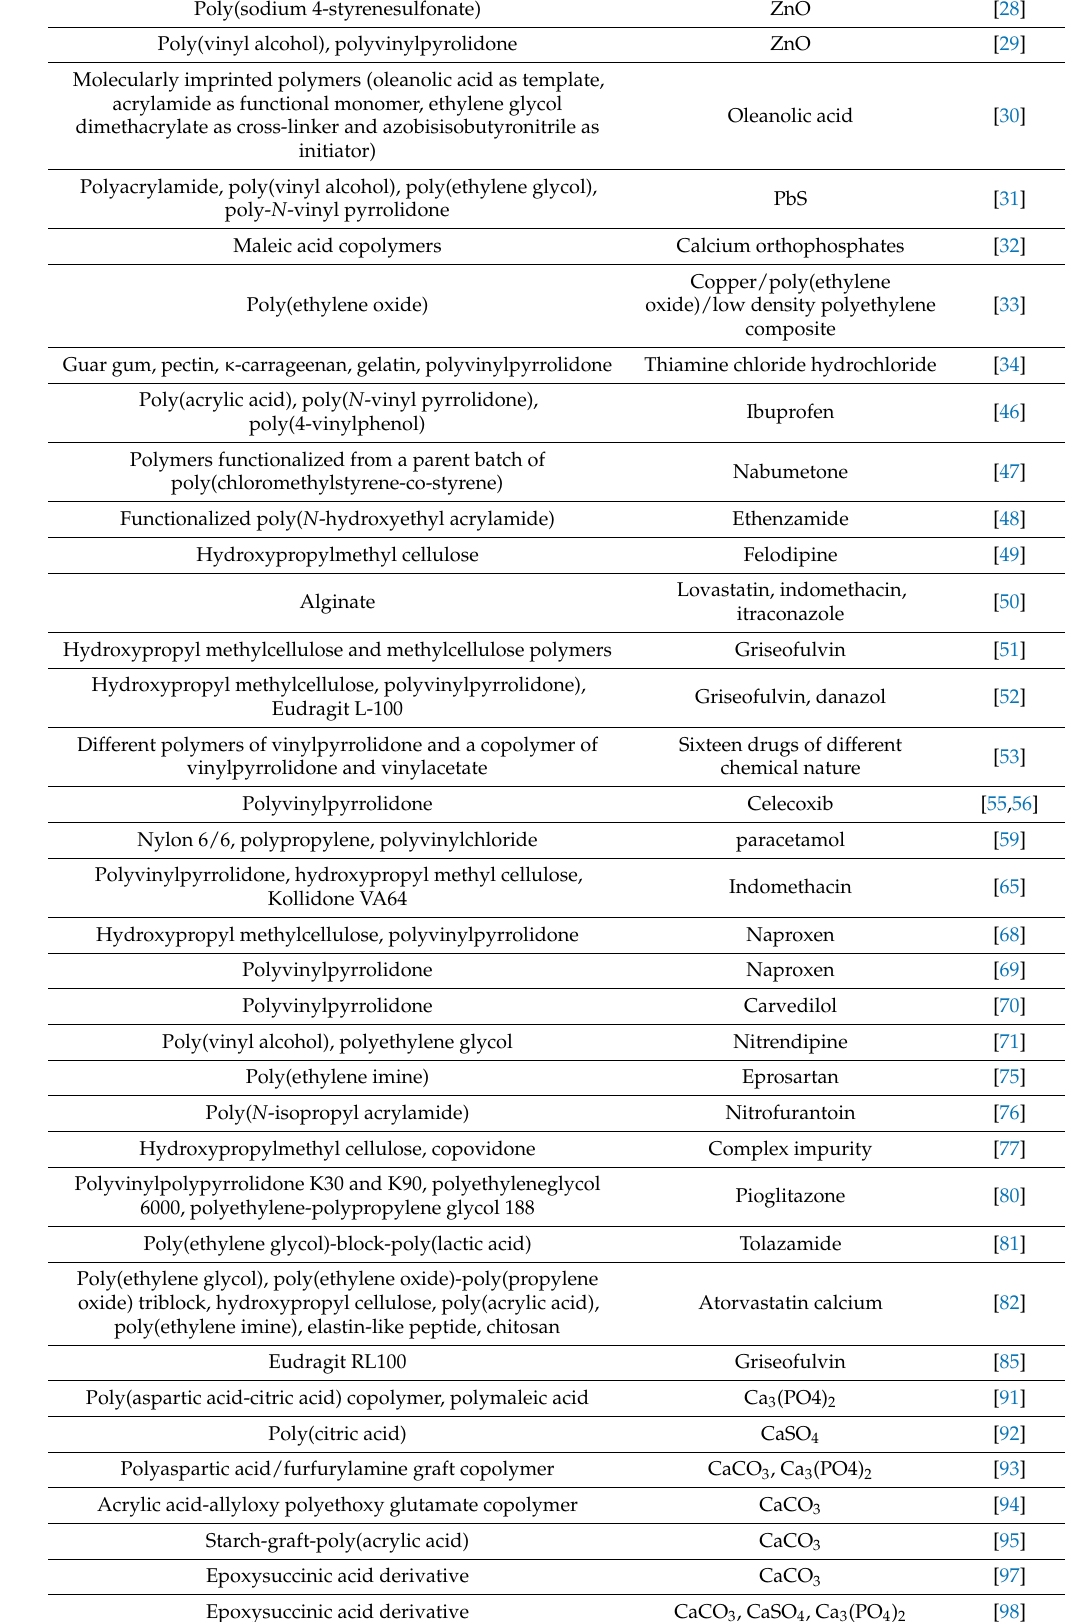
Crystal surface